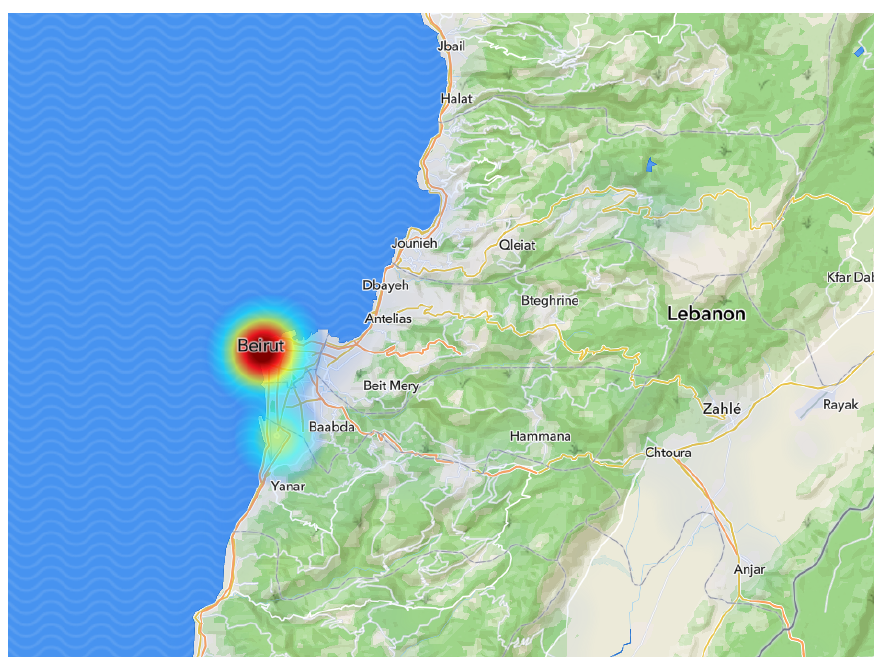
Figure 5. Words cloud of tweets.